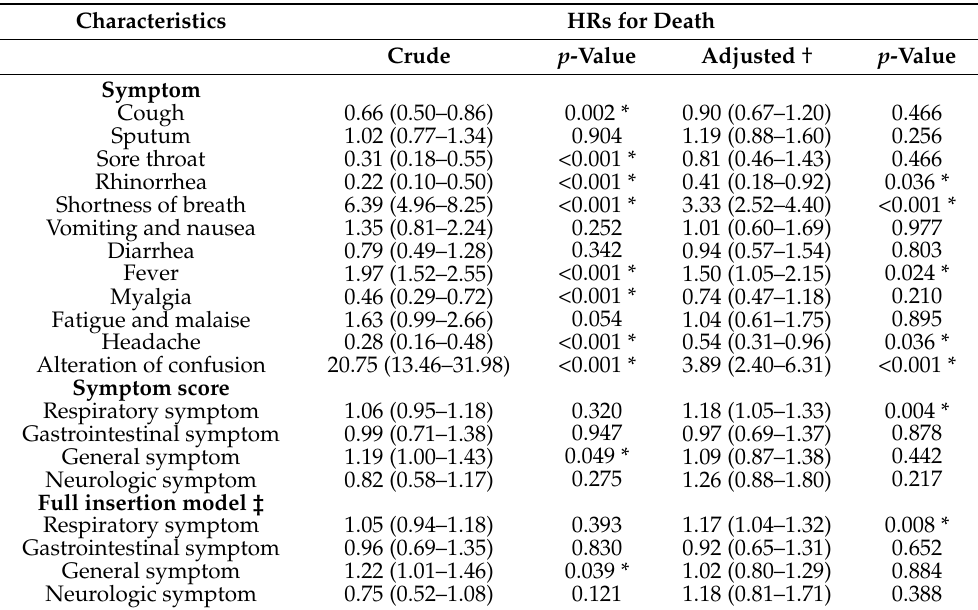
Table 2. Crude and adjusted hazard ratios (95% confidence interval) for death in clinical findings at the time of